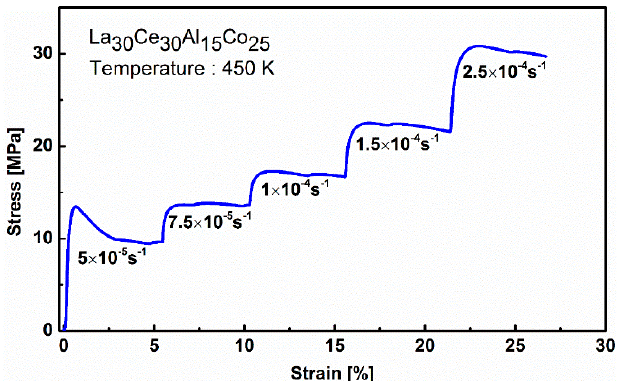
Figure 4. A typical tensile strain-stress curve of La 30 Ce 30 Al 15 Co 25 metallic glass ribbon during strain-rate jump experiments at a given temperature of 450 K.